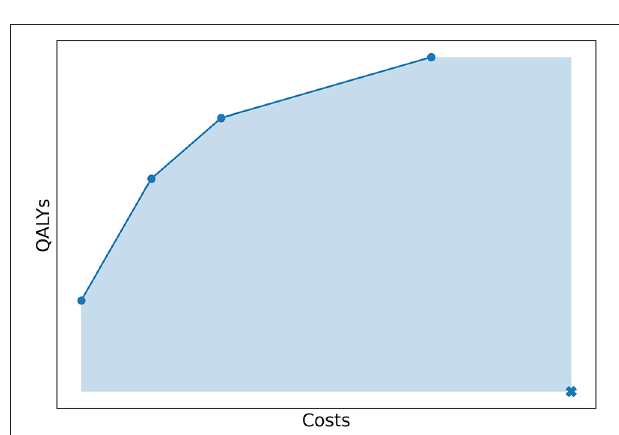
FIGURE 7 | The costs and QALYs of several policies that form a minimal representation of an approximation set. The hypervolume of this approximation set is equal to the area of the objective space dominated by the approximation set, bounded by a reference point. This point is marked with a cross in